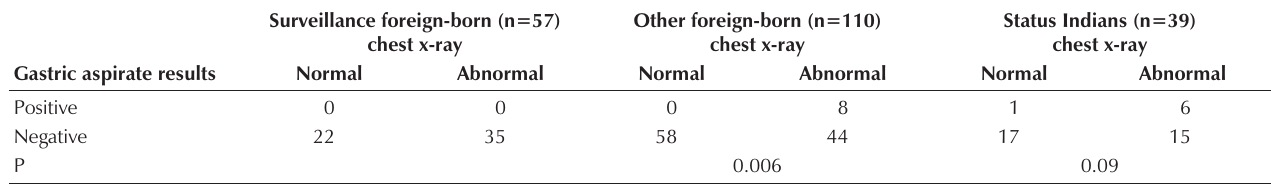
Relationship between the isolation rate of Mycobacterium tuberculosis from gastric aspirates and chest radiographs in each group Surveillance foreign-born (n=57) Other foreign-born (n=110) chest x-ray chest x-ray